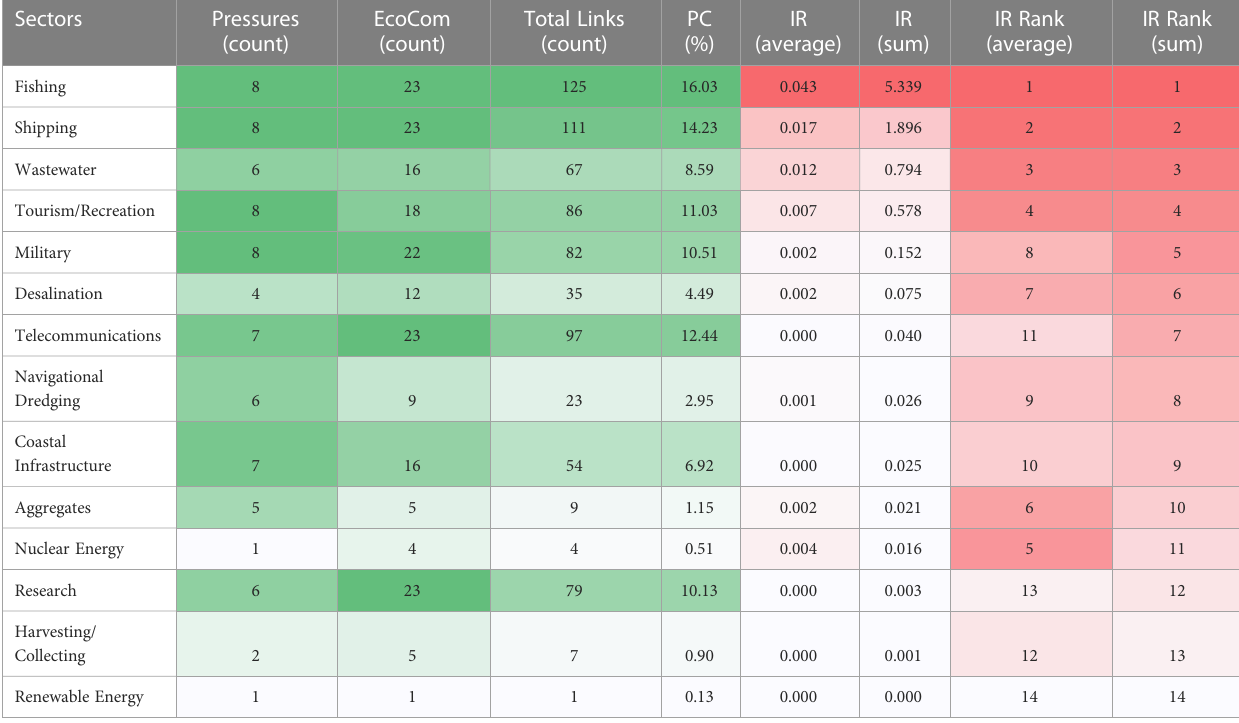
TABLE 4 Rankings of descriptors identi fi ed by the summed and average impact risk (IR) and their proportional connectance (PC), and sum and average risk scores for Sectors.